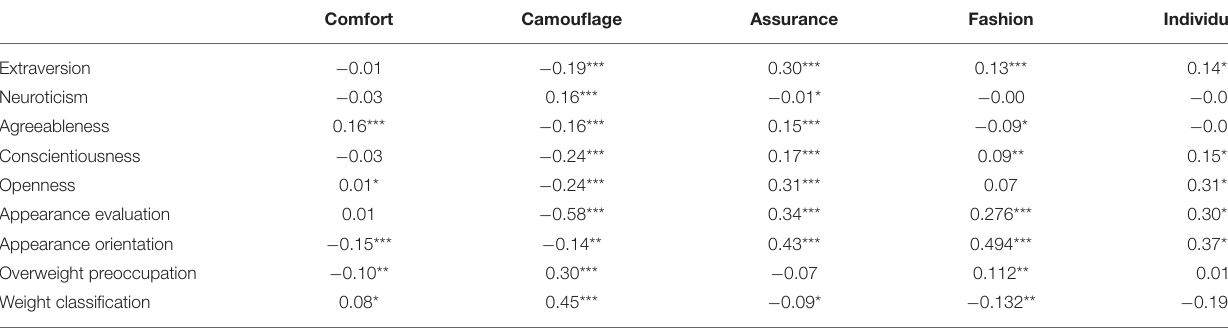
TABLE 2 | Pearson’s correlations among the Big Five personality traits, body image dimensions, and clothing functions ( N = 792). Comfort Camouflage Assurance Fashion Individuality